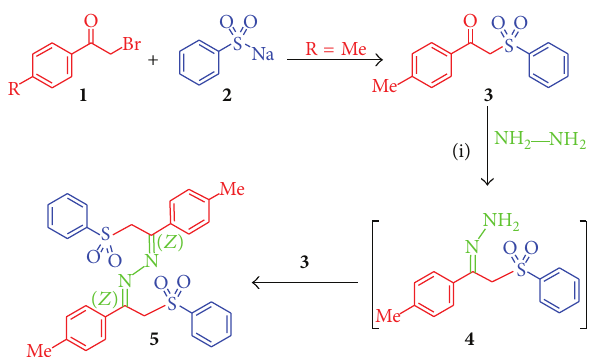
Scheme 1: Synthetic pathway of compound 5 . Reagents and condi- tions: (i) NH 2 –NH 2 (99%)/AcOH, MWI, 100W, 90 ∘ C, 3 min,